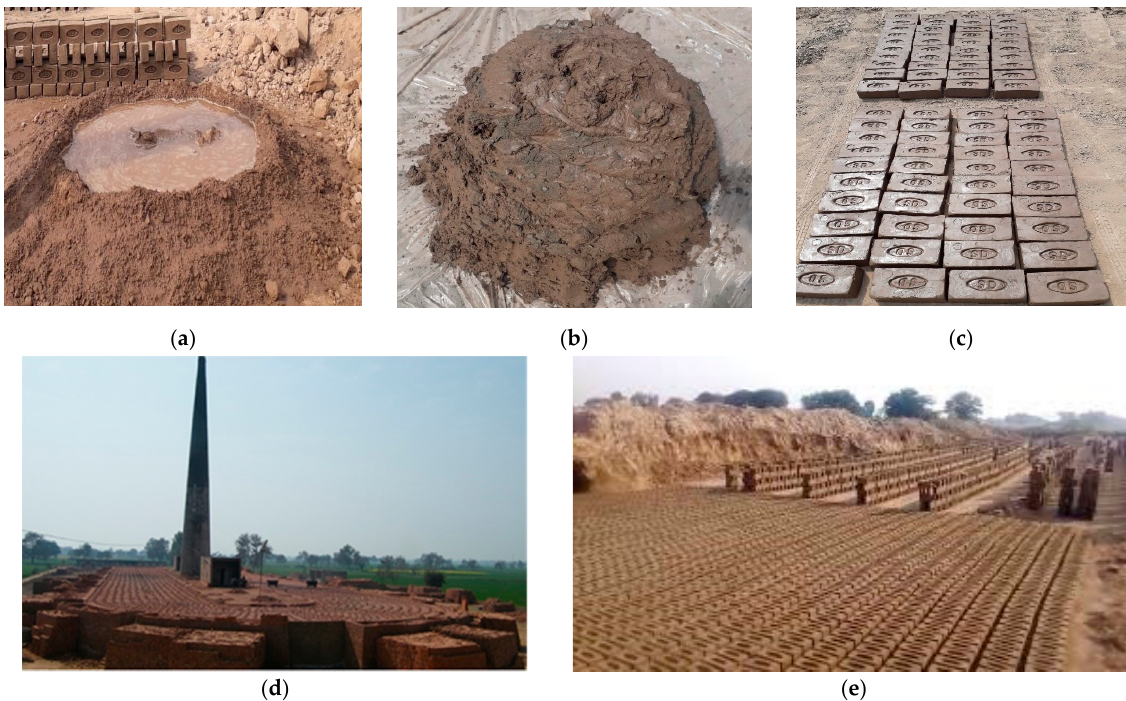
Figure 4. Burnt fired clay manufacturing: ( a ) Wet mixing and voids filling of clay. ( b ) Clay lump. ( c ) Sun drying of demolding specimens. ( d ) Fired in standard Hoffmann kiln. ( e ) Mass production of clay bricks.